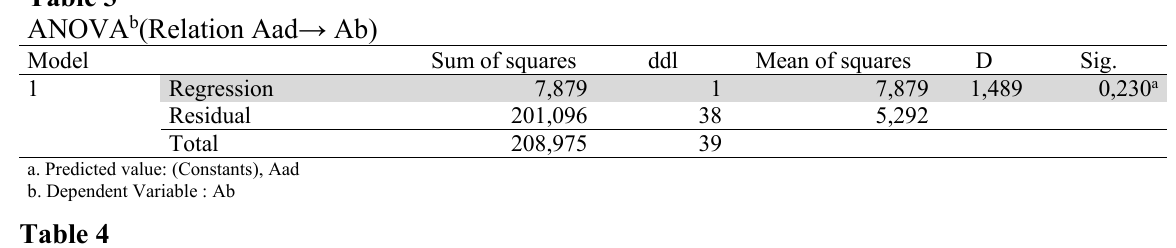
Coefficients a (Relation Aad → Ab) Model